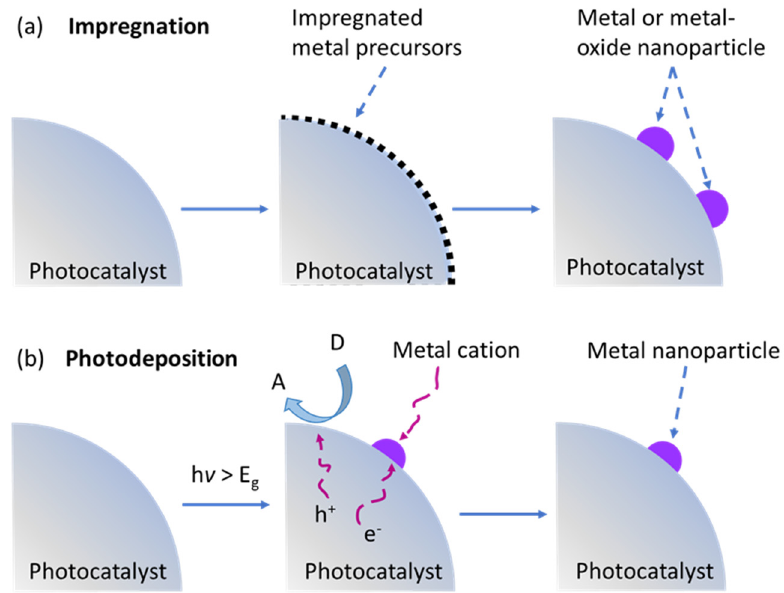
Figure 2. Schematic illustrations of ( a ) impregnation and ( b ) photodeposition method. Domen’s group first reported that a mixed oxide cocatalyst of rhodium and chromium was supported on (Ga 1 − x Zn x )(N 1 − x O x ) by the impregnation method [67]. As the sources of rhodium and chromium, Na 3 RhCl 6 · 2H 2 O and Cr(NO 3 ) 3 · 9H 2 O were loaded on the photocatalyst by immersion method. After calcination, RhCrO x particles with a diameter of 10–20 nm and good crystallization were formed, which were uniformly distributed on the surface of (Ga 1 − x Zn x )(N 1 − x O x ). The apparent quantum yield (AQY) of the samples at POWS achieved was 2.5% at 420–440 nm, which is about an order of magnitude higher than previously reported. The impregnation method can also be compliant with molecular cluster cocatalysts. For example, Seo et al. loaded the synthesized [MO 3 S 4 ] 4+ molecular clusters on the NaTaO 3 surface via the impregnation method and obtained molecular cluster cocatalysts with a diameter of about 1 nm [68]. The hydrogen production rate of POWS is 28 times higher than that of pure NaTaO 3 .